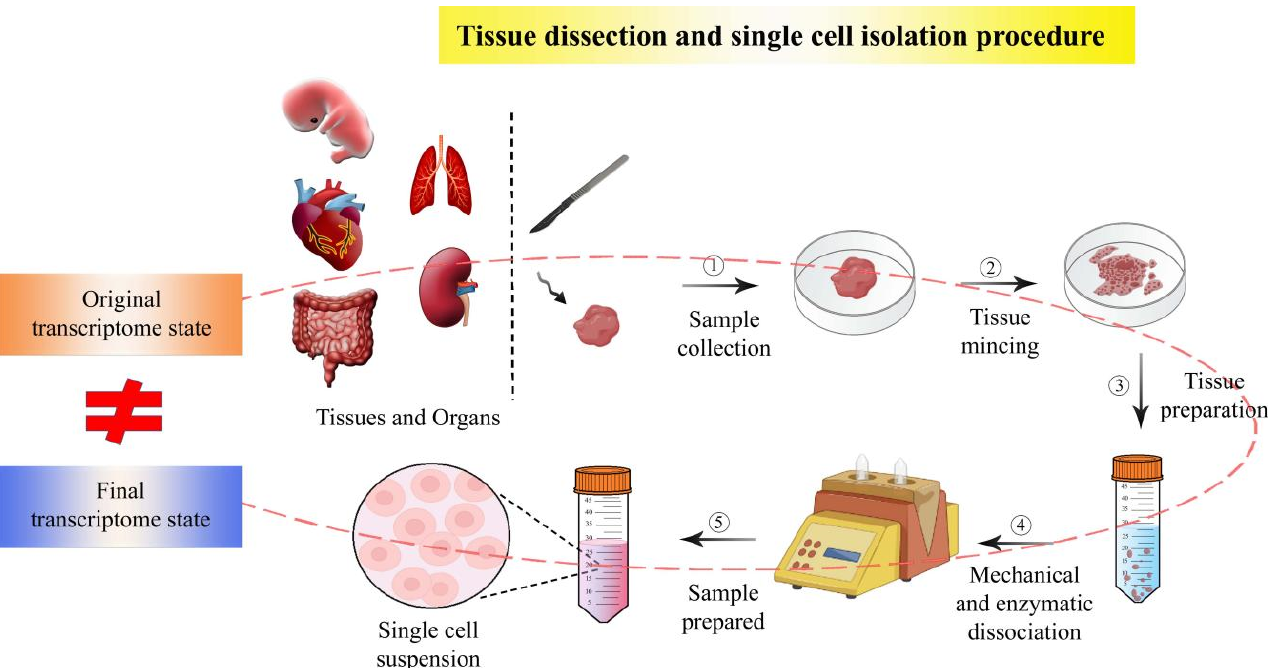
Figure 3. Limitation of the sample preparation protocol for current spatial transcriptomic studies. During the isolation of single cells from solid tissue, single cells undergo in vitro culture and treat- ments, which are different from natural tissue conditions, and their original transcriptome state, therefore, can be seriously affected. Single cells are isolated away from tissues or organs and trans- ferred to in vitro culture medium with various chemicals and enzymes. The mechanical or enzymatic isolation and further non-natural treatments could change cell transcriptome state, consequently affecting the quality of transcriptomes data obtained from currently adopted integrative approaches of scRNA-seq and ST.